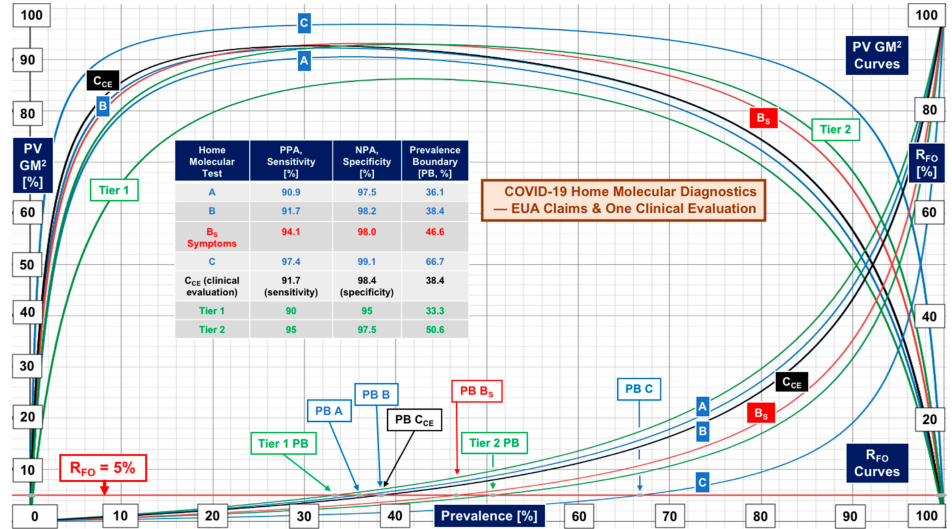
Figure 6. Performance of molecular diagnostics for home self-testing. In the case of home molecular diagnostics, one independent clinical evaluation, shown by the “ C CE ” curves, achieved Tier 1